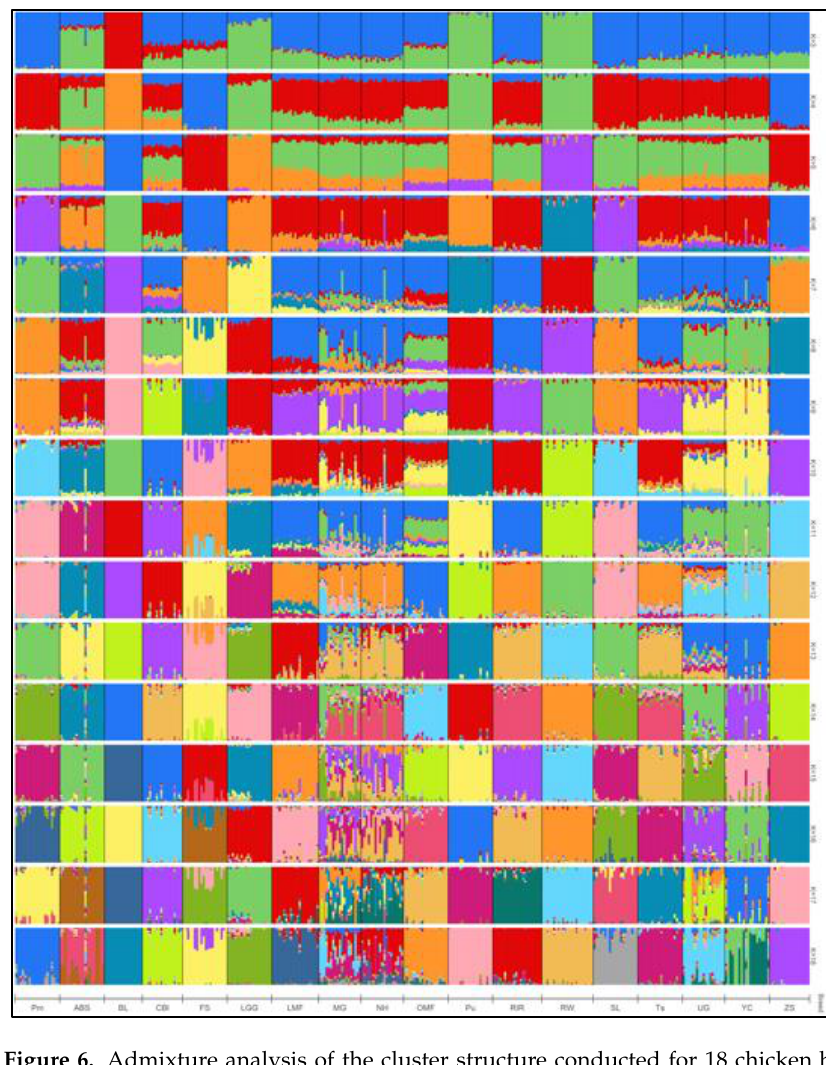
Figure 5. Cross-validation (CV) error in the Admixture analysis based on SNP genotypes in 18 chicken breeds. The optimal number of ancestral populations was K = 16.